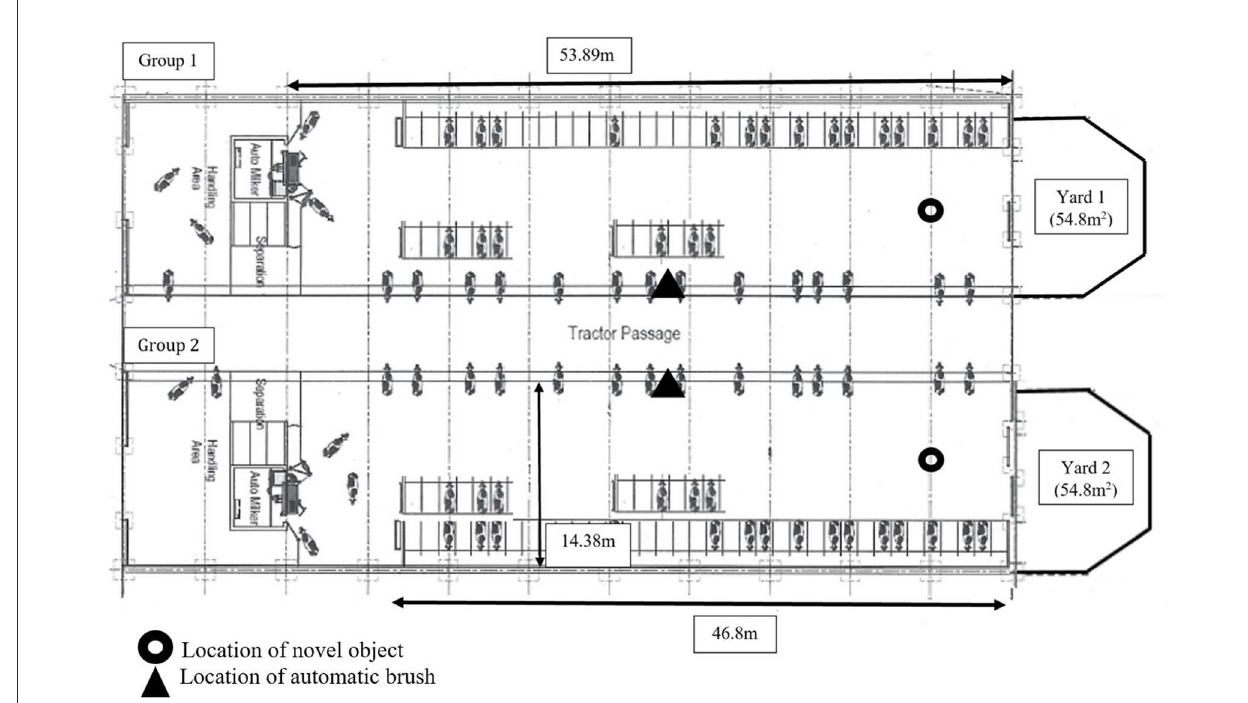
FIGURE1 Schematic view of the experimental housing for both groups of cows within the study.